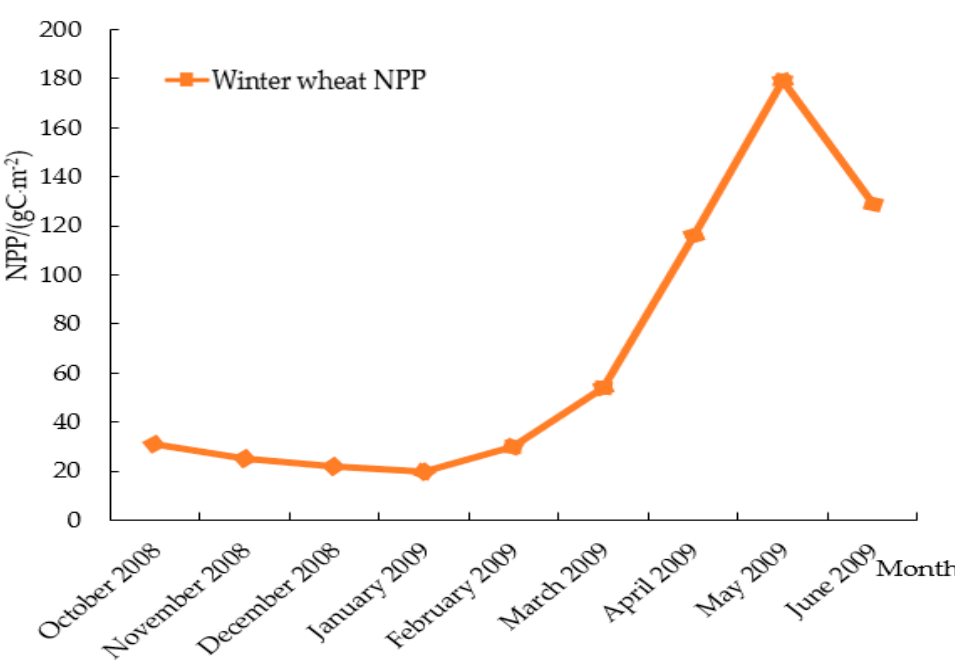
Figure 6. Mean winter wheat NPP as a function of time.